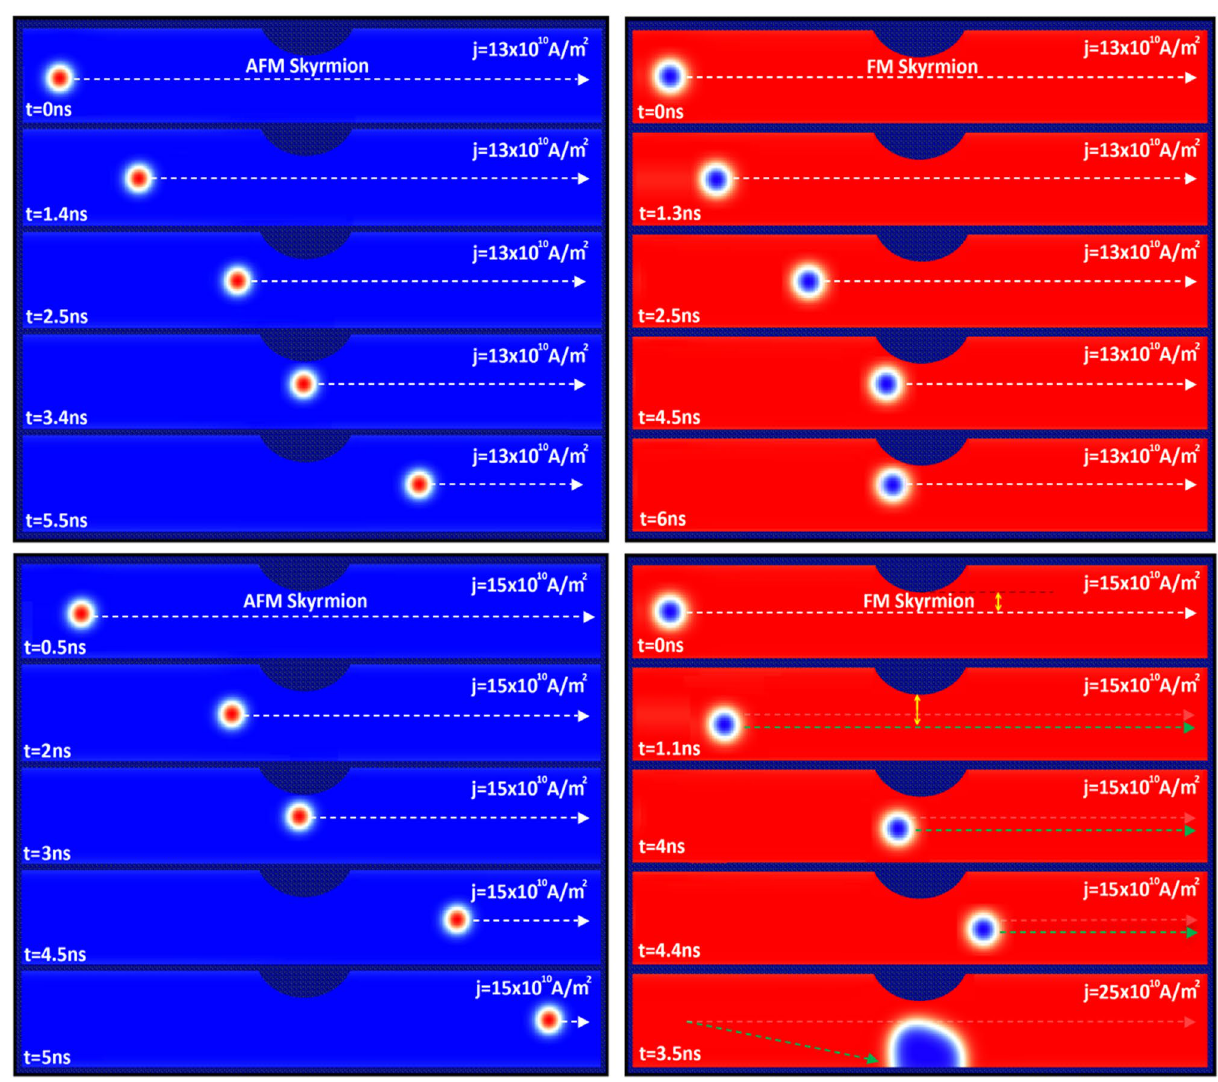
Figure 5. Snapshots of the AFM and FM racetracks during the displacements of AFM and FM skyrmions under different spin-polarized currents (SOTs) with a notch size of R n =18 nm and W n =50 decelerating in the notch area before returning toward the normal path after passing through the notch. For large currents, we observe that the higher current, the smaller deflection therefore the velocity remains almost constant throughout the skyrmion motion along the track memory. Whereas for FM skyrmion, even increasing 10 10 A / m 2 , it is clear that the SOT cannot overcome the repulsive forces, and the spin polarization current to 13 × hence the skyrmion cannot exceed the notch. This result is basically due to the skyrmion size in the FM track which is somewhat larger than the AFM skyrmion, and thus the repulsive forces are rather decisive in this case. 10 10 A / m 2 , However, this issue can be avoided by increasing the spin-polarized currents to specific values of 15 × 10 10 A / m 2 , and 20 10 10 A / m 2 where the transverse velocity component leads the FM skyrmion away 18 × × from the notch, which reduces the repulsive forces (Fig. 5). As a result, the FM skyrmion keeps moving next to the edge under these current densities without being annihilated. Although, it should be noted that the SkHE grows with the spin-polarized currents in the FM racetrack. Therefore, for large current densities, SkHE drives FM skyrmions to annihilate at the track edge. We point out that if we consider the notch at the opposite edge, the FM skyrmion will either annihilate or stop at the notch depending on SOT strengths, because the Magnus force drives the skyrmion to the notch which contributes to an increase in repulsive forces between the notch and skyrmion. Thus, the FM skyrmion will be unable to pass through the notch for all SOT strengths unless the direction of the Magnus force is reversed. In Fig. 5, we illustrated the displacements of AFM and FM skyrmions along a racetrack notched with a notch 18nm and W 50nm for various spin-polarized currents (SOTs). When skyrmion motions in AFM size of R n n = = 10 10 A / m 2 ), we find that the deflec- and FM racetracks are compared under the same spin-polarized current (15 × tion in FM skyrmion is lower because SkHE plays here a positive role by reducing the notch edge forces, but at 10 10 A / m 2 , FM skyrmion collides with the edges and is destroyed. large currents above 20 ×